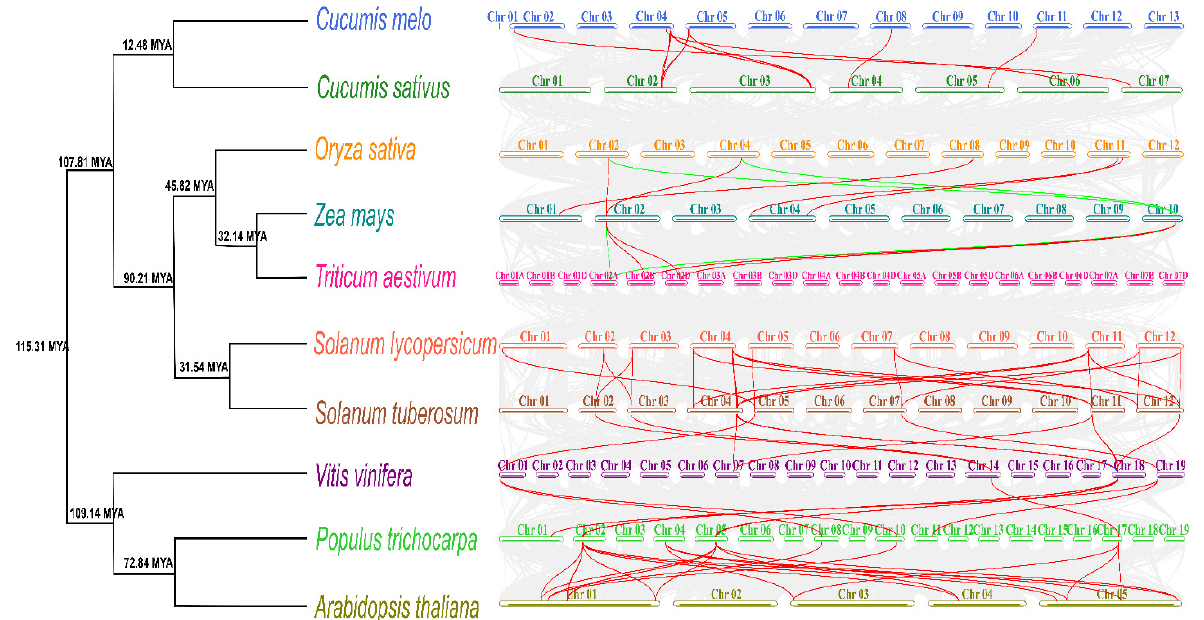
Figure 5. Divergence times and synteny of 14-3-3s among the 10 species. The left side of the figure shows the constructed evolutionary divergence tree with the divergence time labeled above the branches. In the middle are the Latin names of 10 different species. The long bars of different colors on the right side represent the chromosomes of different species. The gray line indicates the synteny of all genes between different species. The red line indicates the synteny of 14-3-3s between different species. The green line indicates the synteny between the 14-3-3s of one species and the non- 14-3-3s of another species.